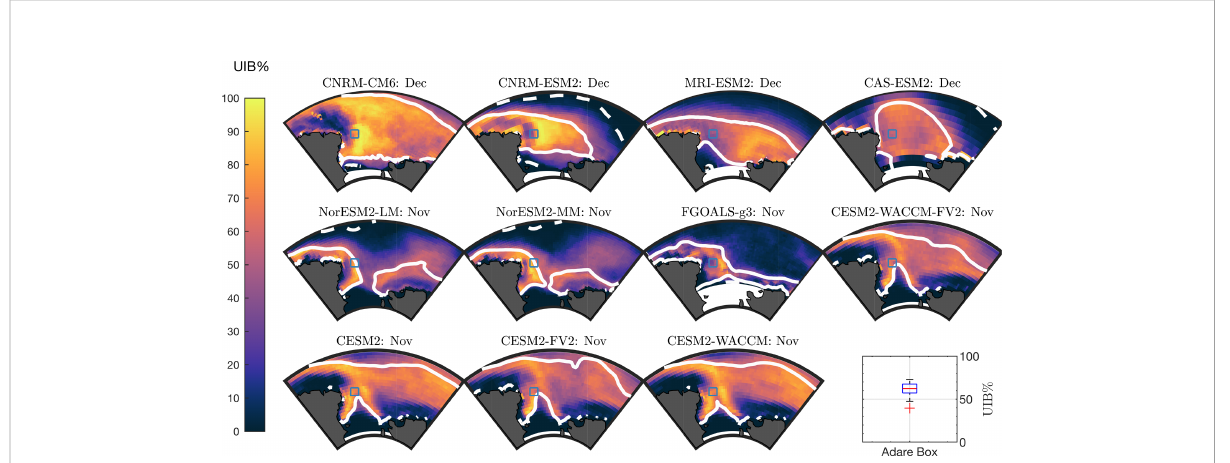
FIGURE 5 UIB likelihoods in the Ross Sea. Ross Sea UIB% for each model in the month of the maximum UIB area. Solid lines are climatological CIZ. Dashed lines are climatological SIE. Blue square highlights the location of interest at 72°S,178°E. Box plot (bottom right) is of UIB% at square